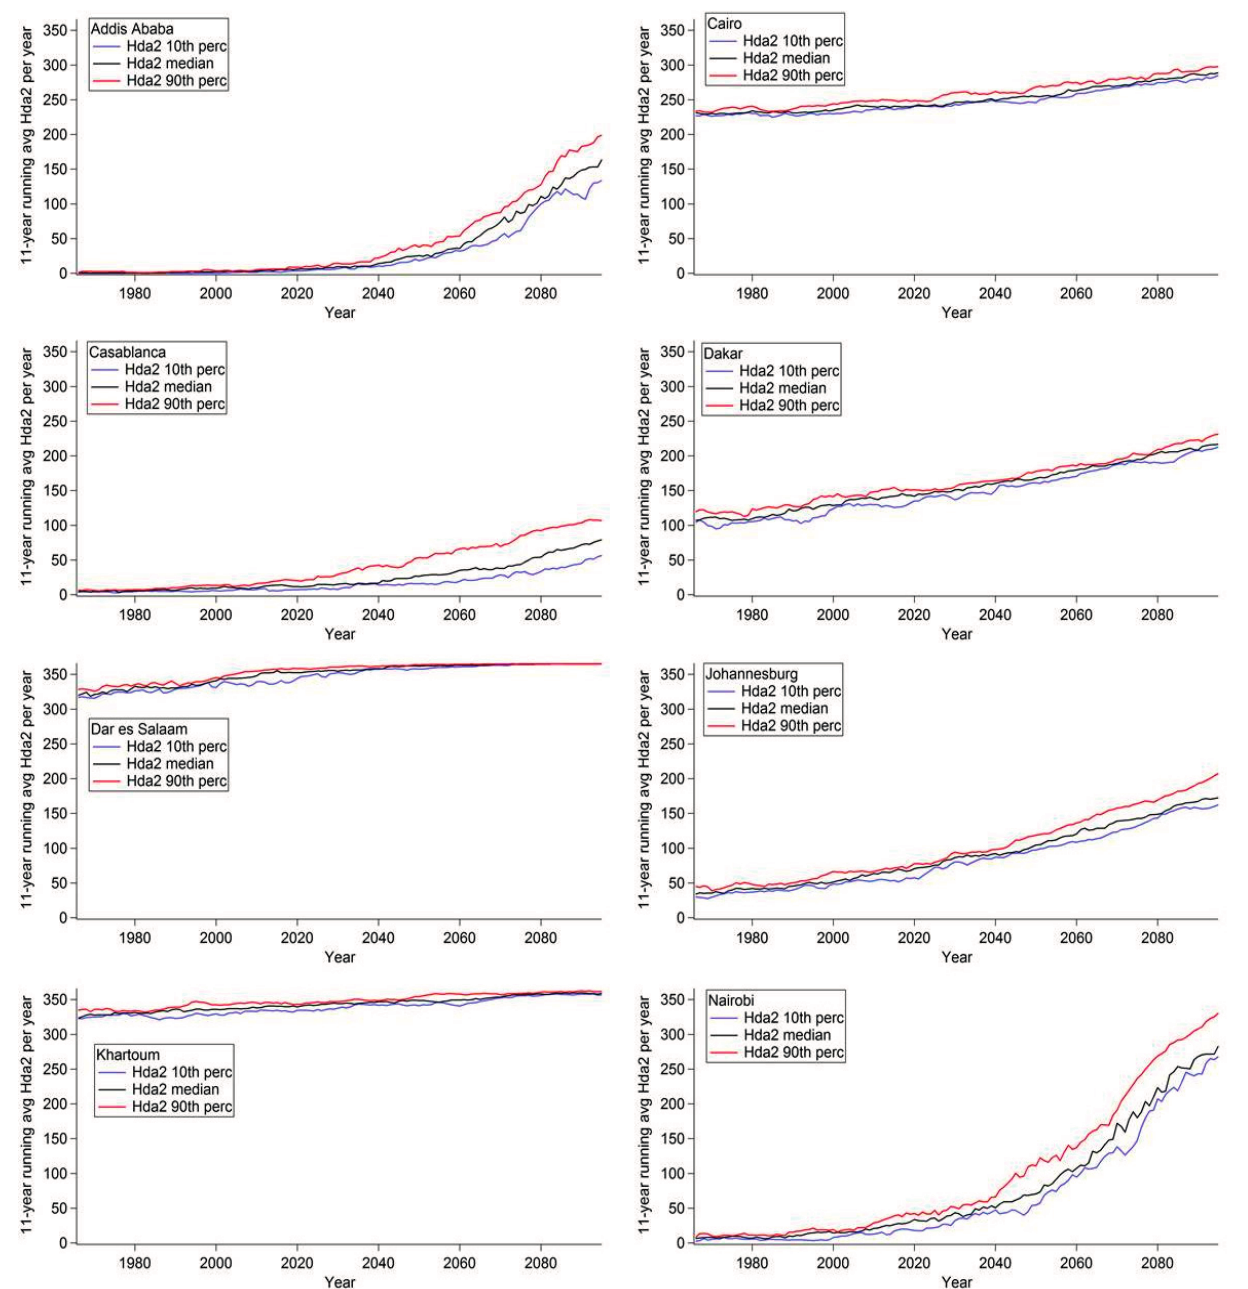
Figure 4. Eleven-year moving average of the number of Hda2 per year in selected cities in Africa. The ensemble 10th percentile (blue), the ensemble median (black) and the ensemble 90th percentile (red) of number of days per year are